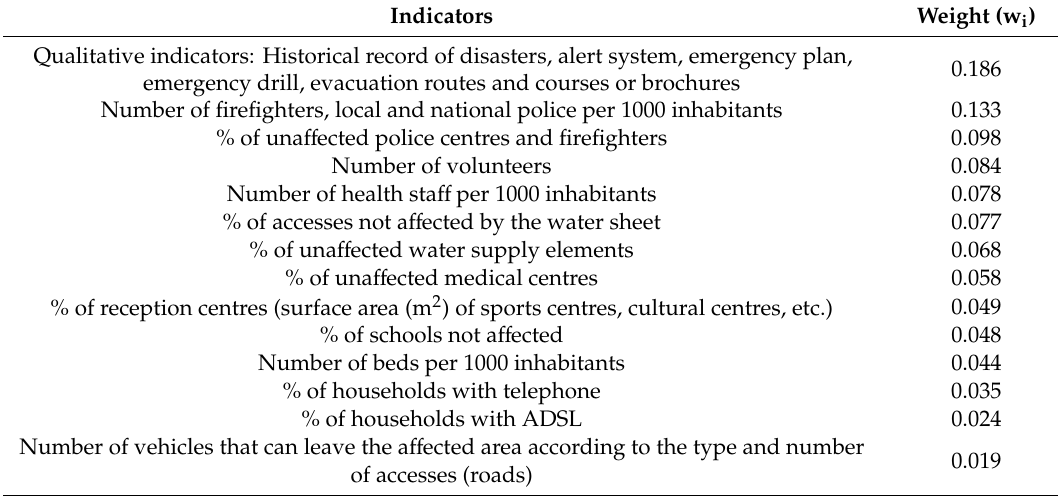
Table 4. Weights of indicators that indicate the resistance of social